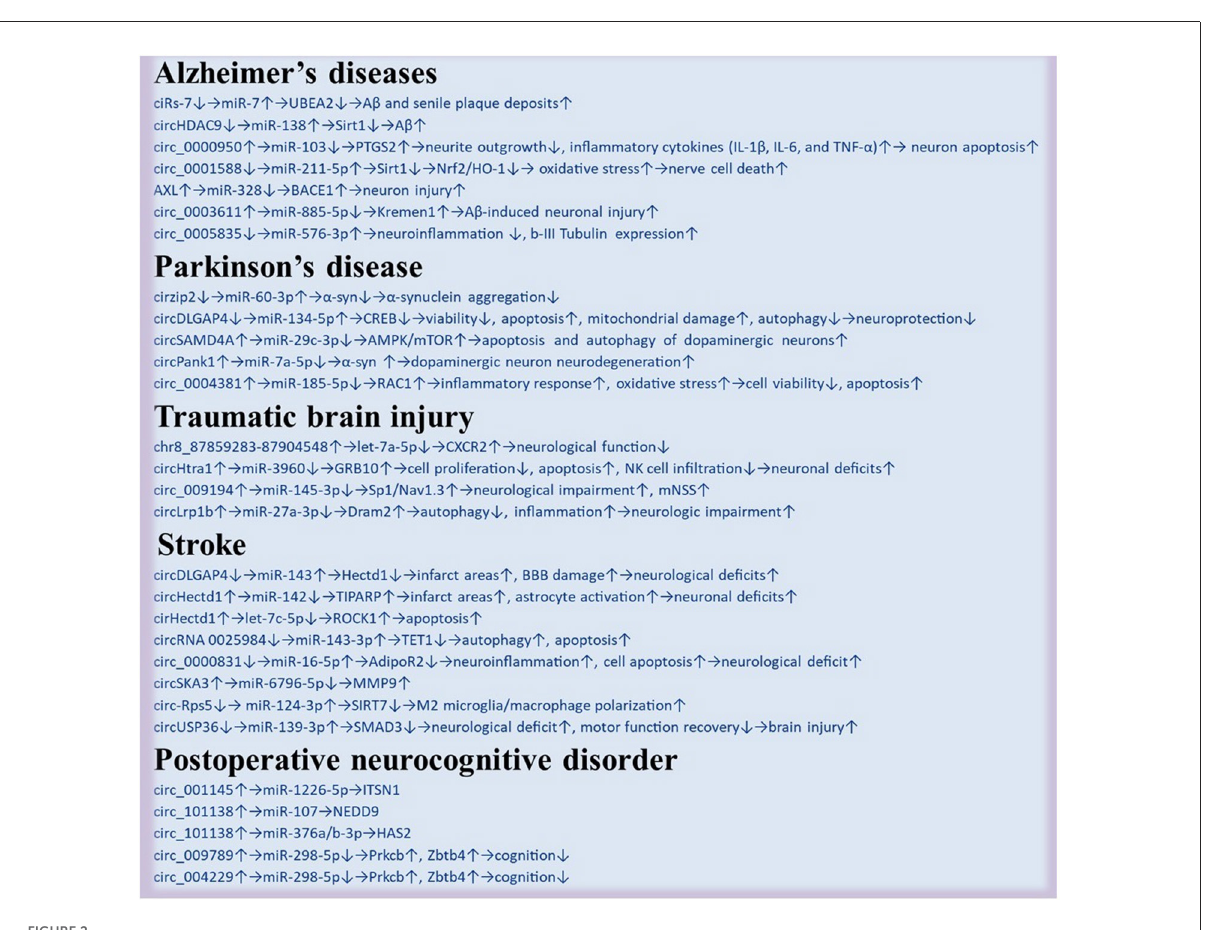
FIGURE2 Regulatory networks of circRNA–miRNA–mRNA in various brain disorders. Changes in the regulatory networks of circRNA–miRNA–mRNA and potential signaling pathways are presented.